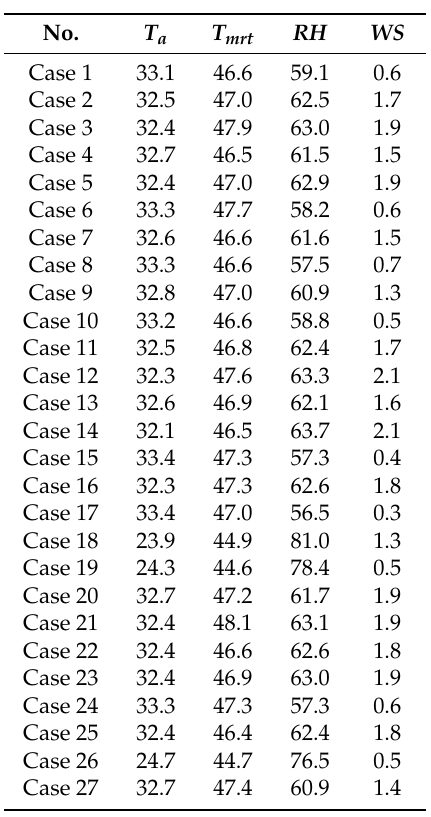
Table 6. ENVI-met simulation results for 27 cases (meteorological factors).